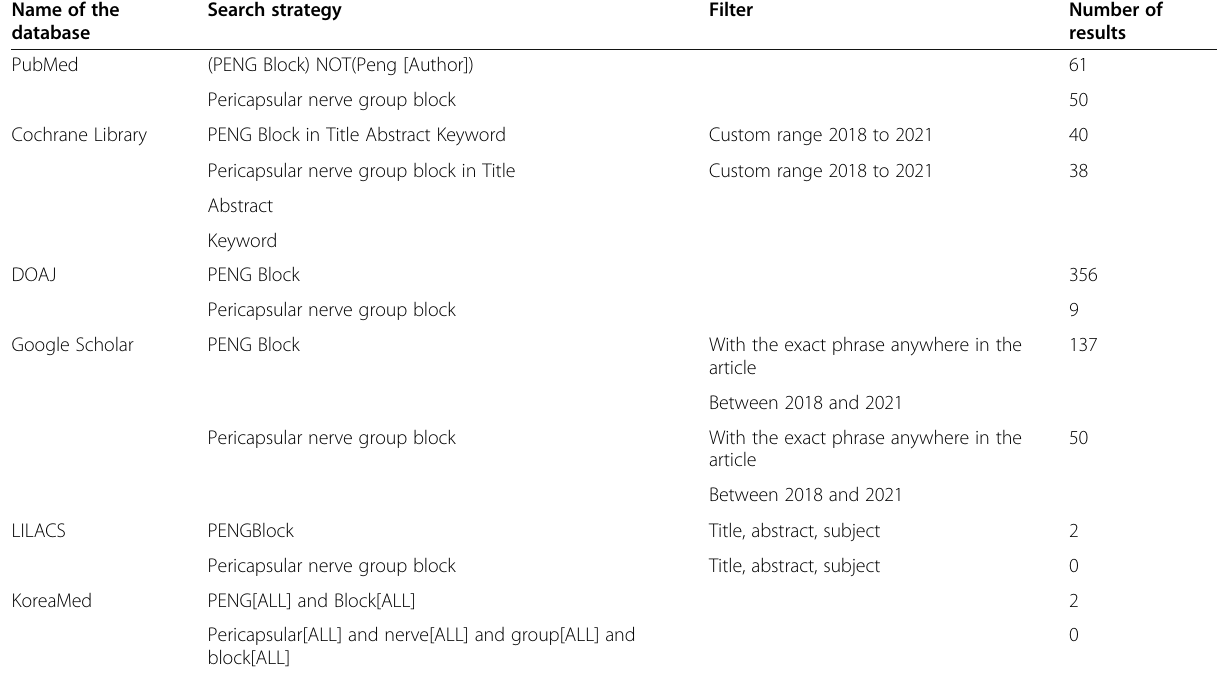
Table 1 Search strategy and results of database search on 10th Jan 2021